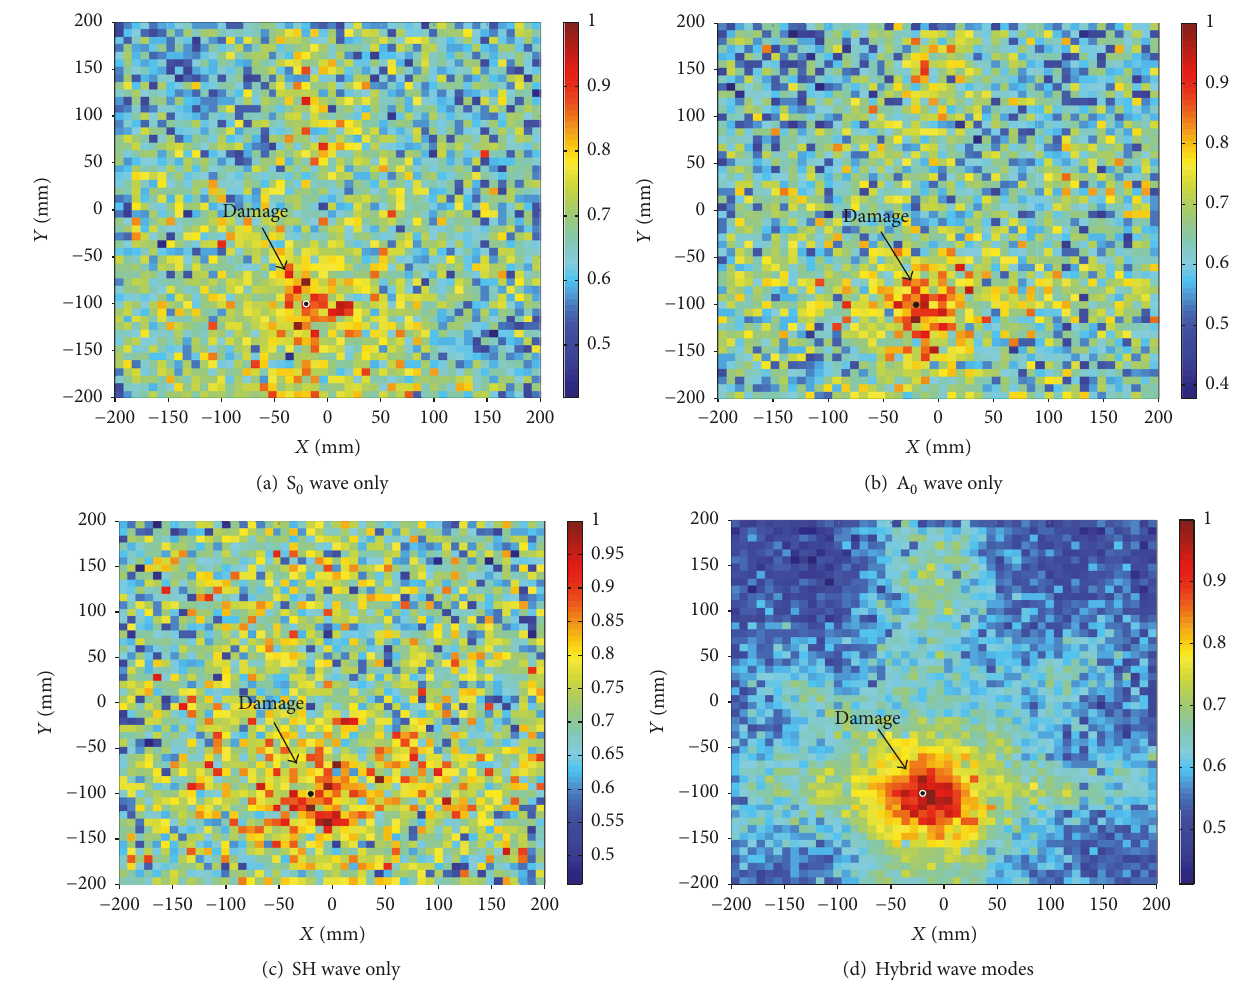
Figure 11: Comparison of damage maps (FE simulation).